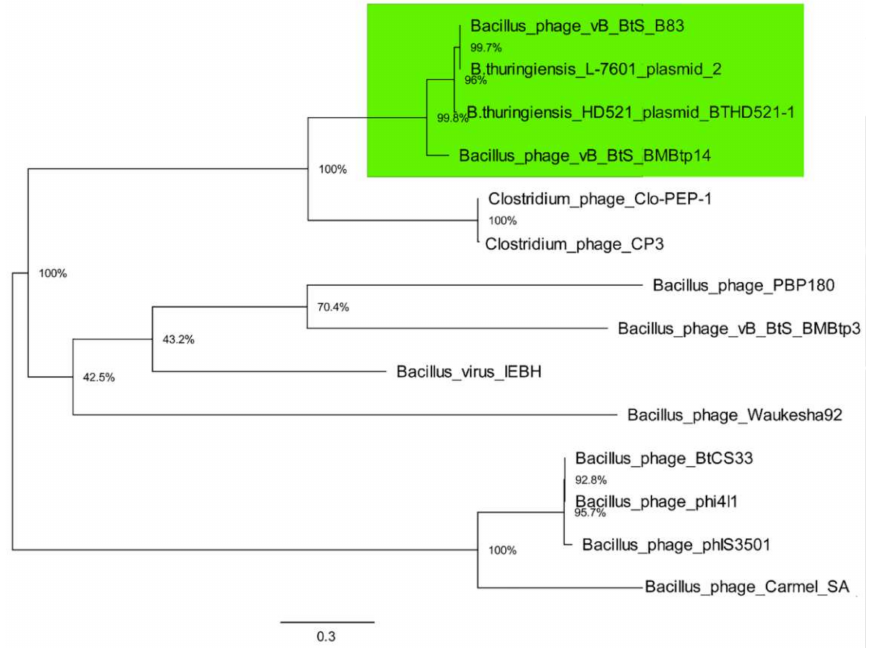
Figure 6. Phylogenetic analysis of amino acid sequences of TerL of 14 phages using maximum likelihood (Whelan and Goldman substitution model), with 1000 bootstrap replicates. Scale bar represents the number of amino acid substitutions per site. The clade containing the members of the proposed new genus is highlighted in